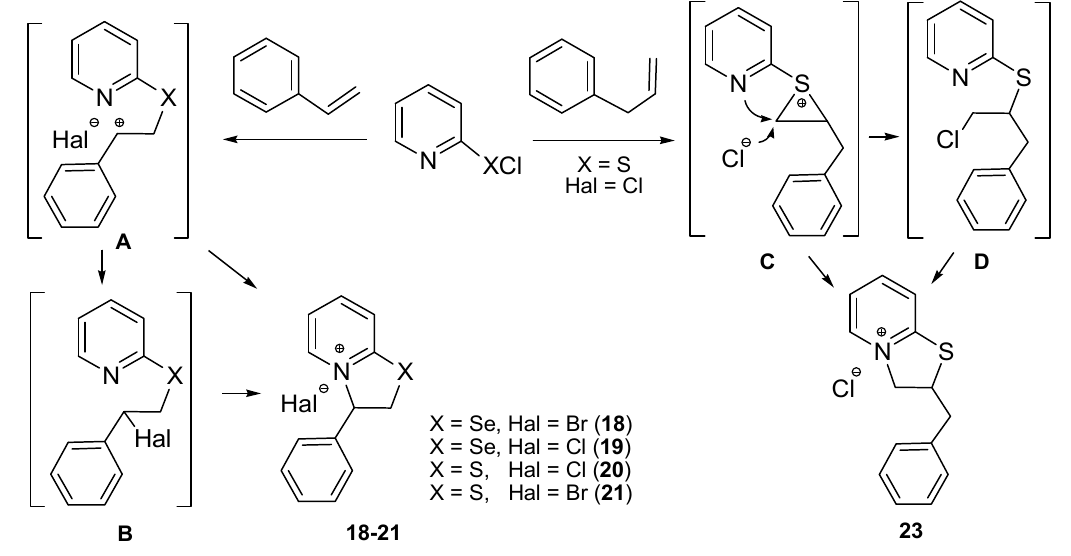
Scheme 6. The suggested reactions pathways on the example of reactions of 2-pyridinesulfenyl and selenenyl halides with styrene and allylbenzene.